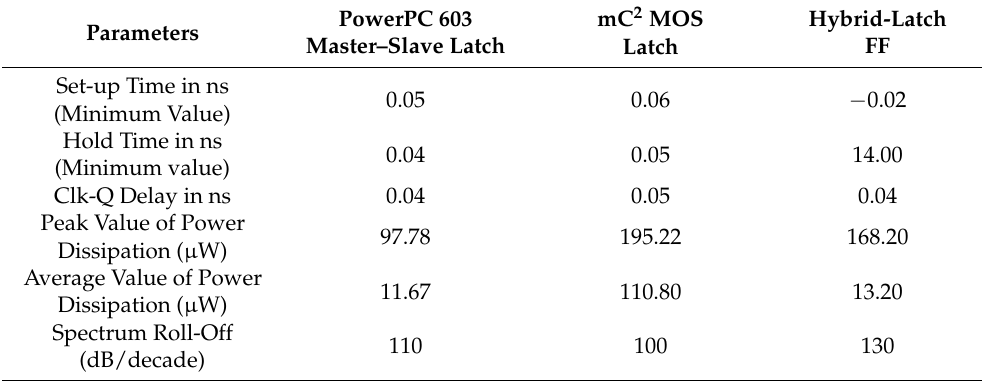
Table 3. Simulation results using the BSIM4 transistor model (65 nm process technology).